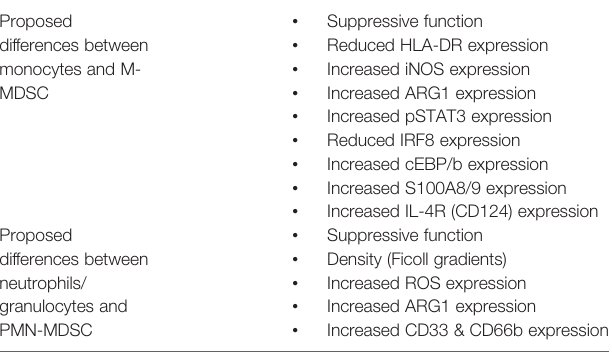
TABLE 1 | Differences between MDSCs and other myeloid